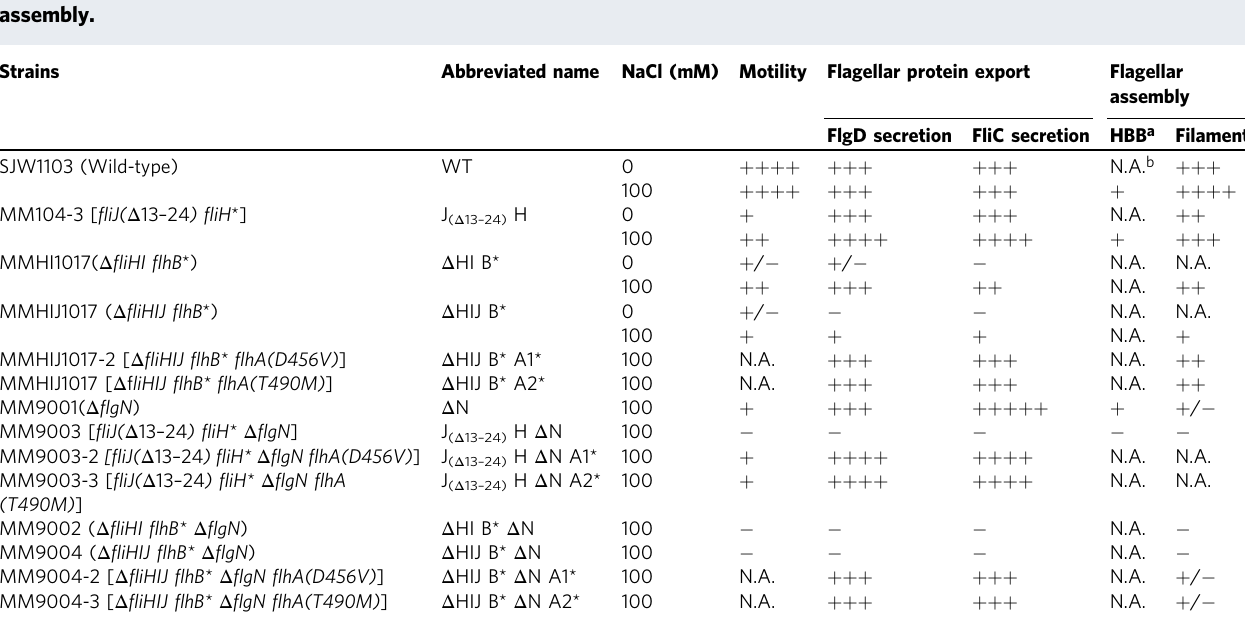
Table 1 Summary for important properties of Salmonella strains with respect to motility, fl agellar protein export and fl agellar